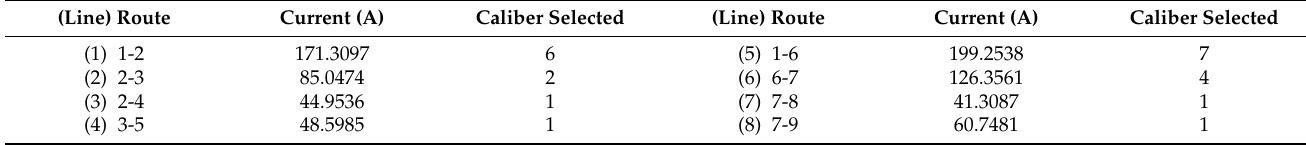
Table 9. Ideal current consumption of each route in the alternative solution for the 9-bus system. (Line)